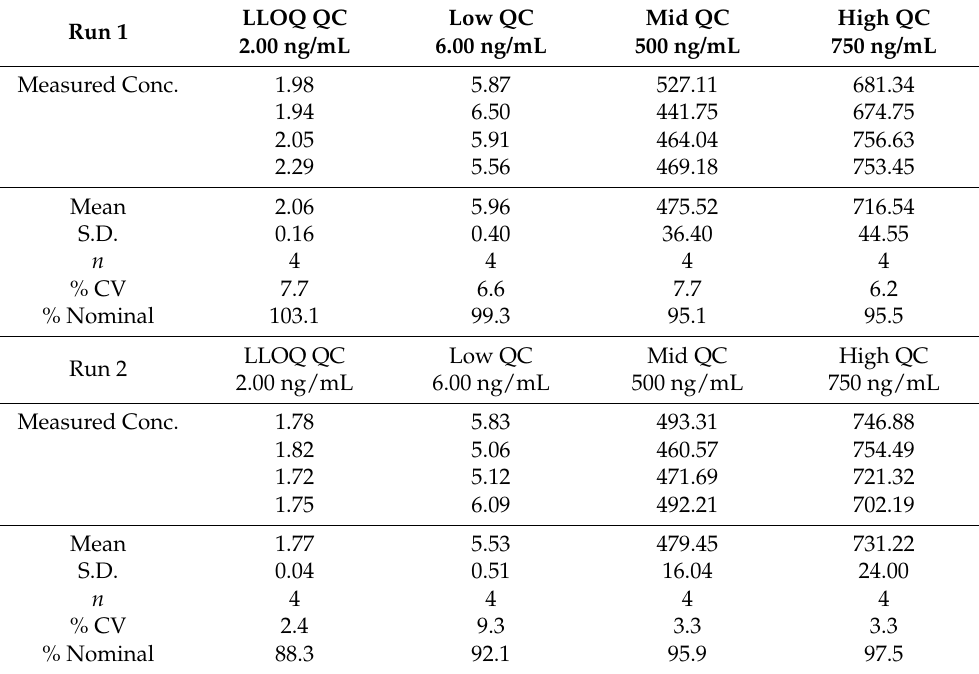
Table 3. Accuracy and precision of siRNA-01 QCs in monkey